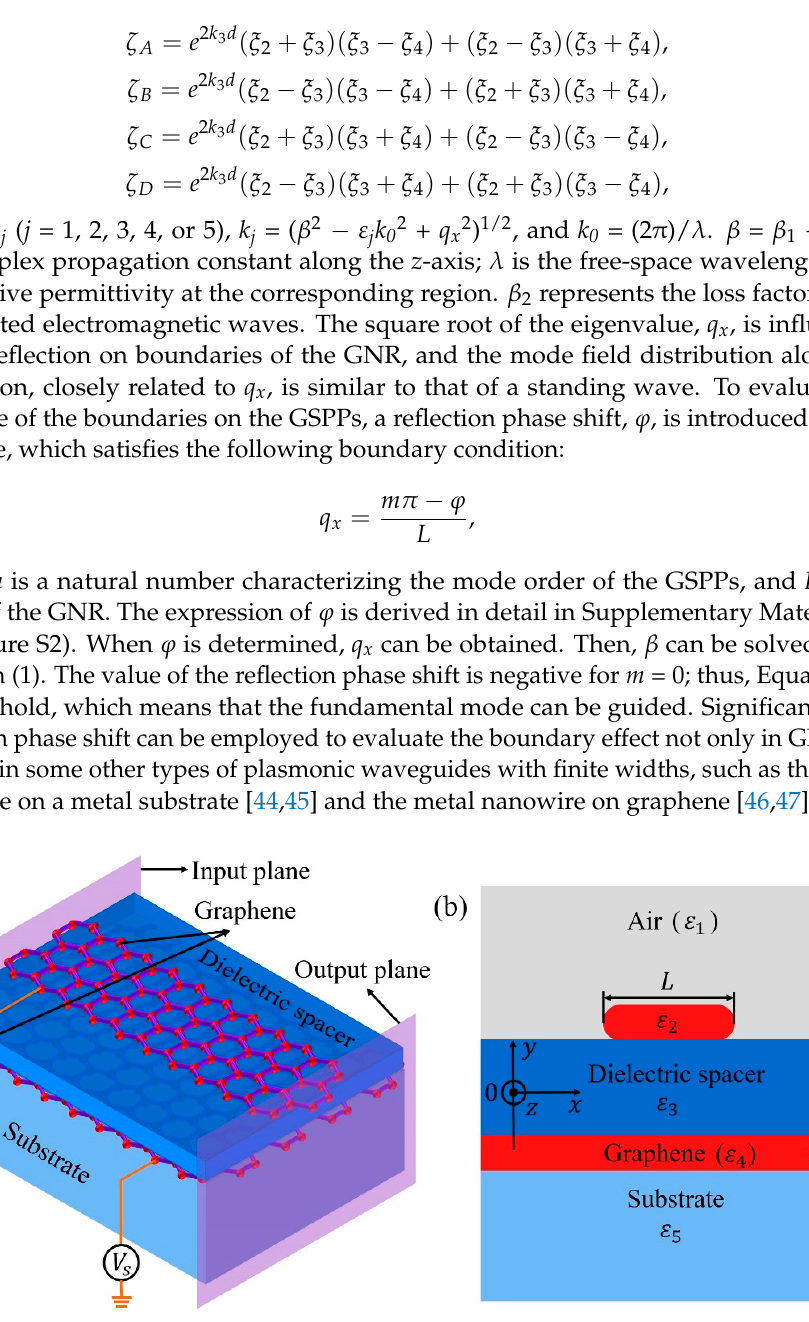
Figure 1. The schematic diagram of the GNRGW: ( a ) the 3D model; ( b ) the cross-sectional view in the x - y plane.